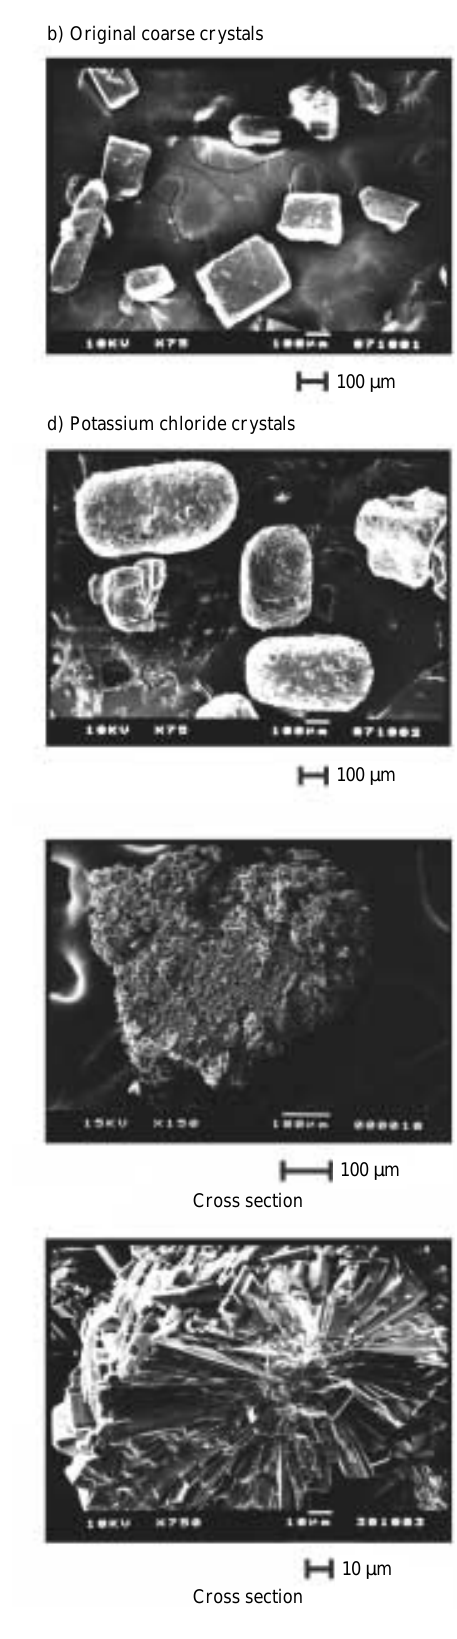
Scanning electron photomicrographs of external appearance and cross-section of original ascorbic acid crystals, a C97 granule, potas- sium chloride crystals, and SA and ESD agglomerated crystals of